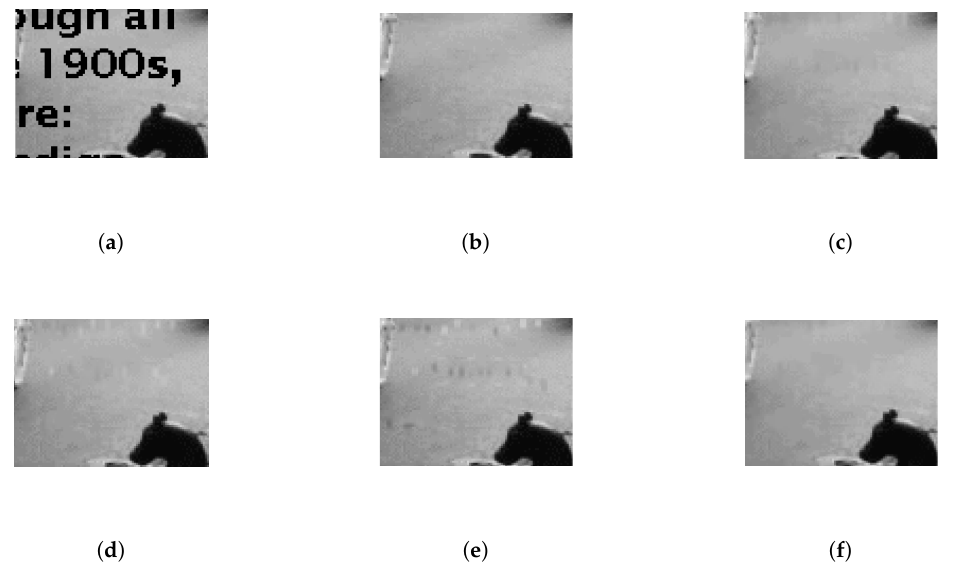
Figure 7. Close-up comparisons of Figure 6. ( a ) zoomed portion of Figure 6a; ( b ) zoomed portion of Figure 6b; ( c ) zoomed portion of Figure 6c; ( d ) zoomed portion of Figure 6d; ( e ) zoomed portion of Figure 6e; ( f ) zoomed portion of Figure